Question: Briefly state, in one sentence, what is plotted here.
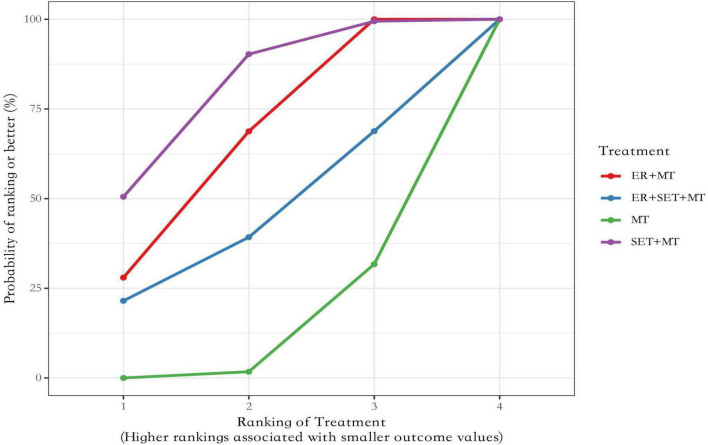
Answer: Ranking probability plot for amputation incidence. Higher rankings are associated with lower amputation risk.